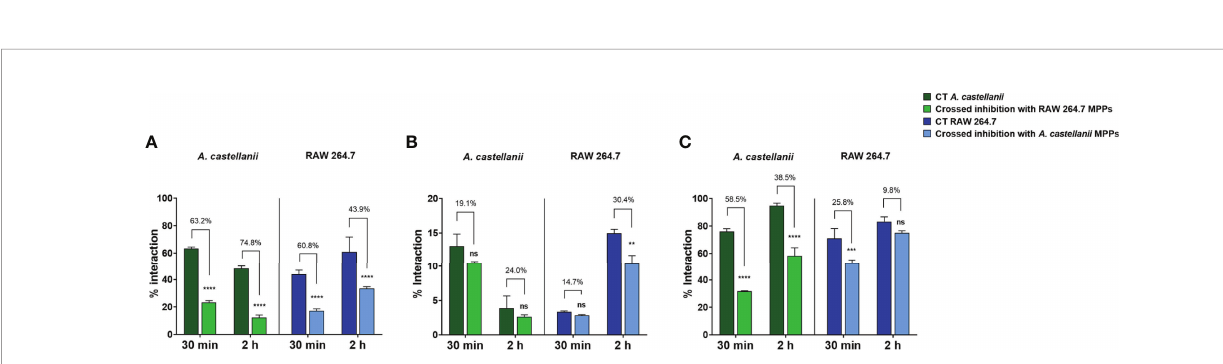
FIGURE 6 | Acanthamoeba castellanii and RAW mannose-binding lectins share the same binding targets onthe fungal cell wall. (A) Candida albicans , (B) Cryptococcus neoformans and (C) Histoplasma capsulatum yeasts were pre-incubated with 50 µg/mLof either A. castellanii or RAW 264.7 MPPs. After thisstage, cross-inhibitions were evaluated, where yeasts pre-treated with RAW 264.7 MPPs interacted with A. castellanii (light green bar) and comparedto controls in the absence of inhibition(dark greenbar). Additionally, yeasts pre-treated with A. castellanii MPPs interacted withRAW 264.7 macrophages (light blue bar), and compared to controls inthe absence of inhibition(dark blue bar). Interactions were performed for 30 minand 2 h, to evaluate the initial fungal adhesionandthe late interactions, respectively. Inhibition percentages (numbers above bars) were calculatedfrom the interactionpercentages as follows: (Control - Pre-treatedgroup) x 100/Control. The statisticalsigni fi cances comparing inhibition x controls are represented above eachgroup (**p < 0.01; ***p< 0.001; ****p < 0.0001; ns, not signi fi cant). The bars represent the average ofthree independent experiments, performed in